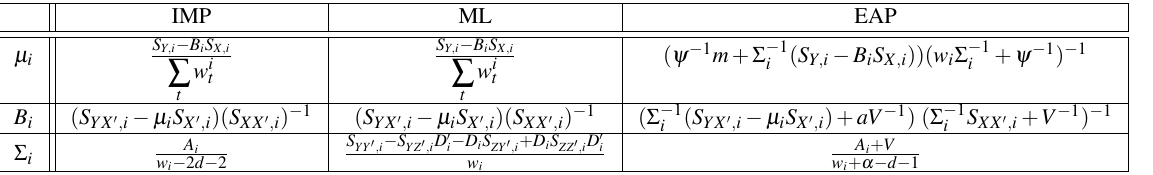
Table 2: Estimation of conditional Gaussian distribution parameters ( µ i , B i , Σ i ) obtained by Implicit method (section 4), Maximum of Likelihood ( 9 ) and Expectation A Posteriori (section